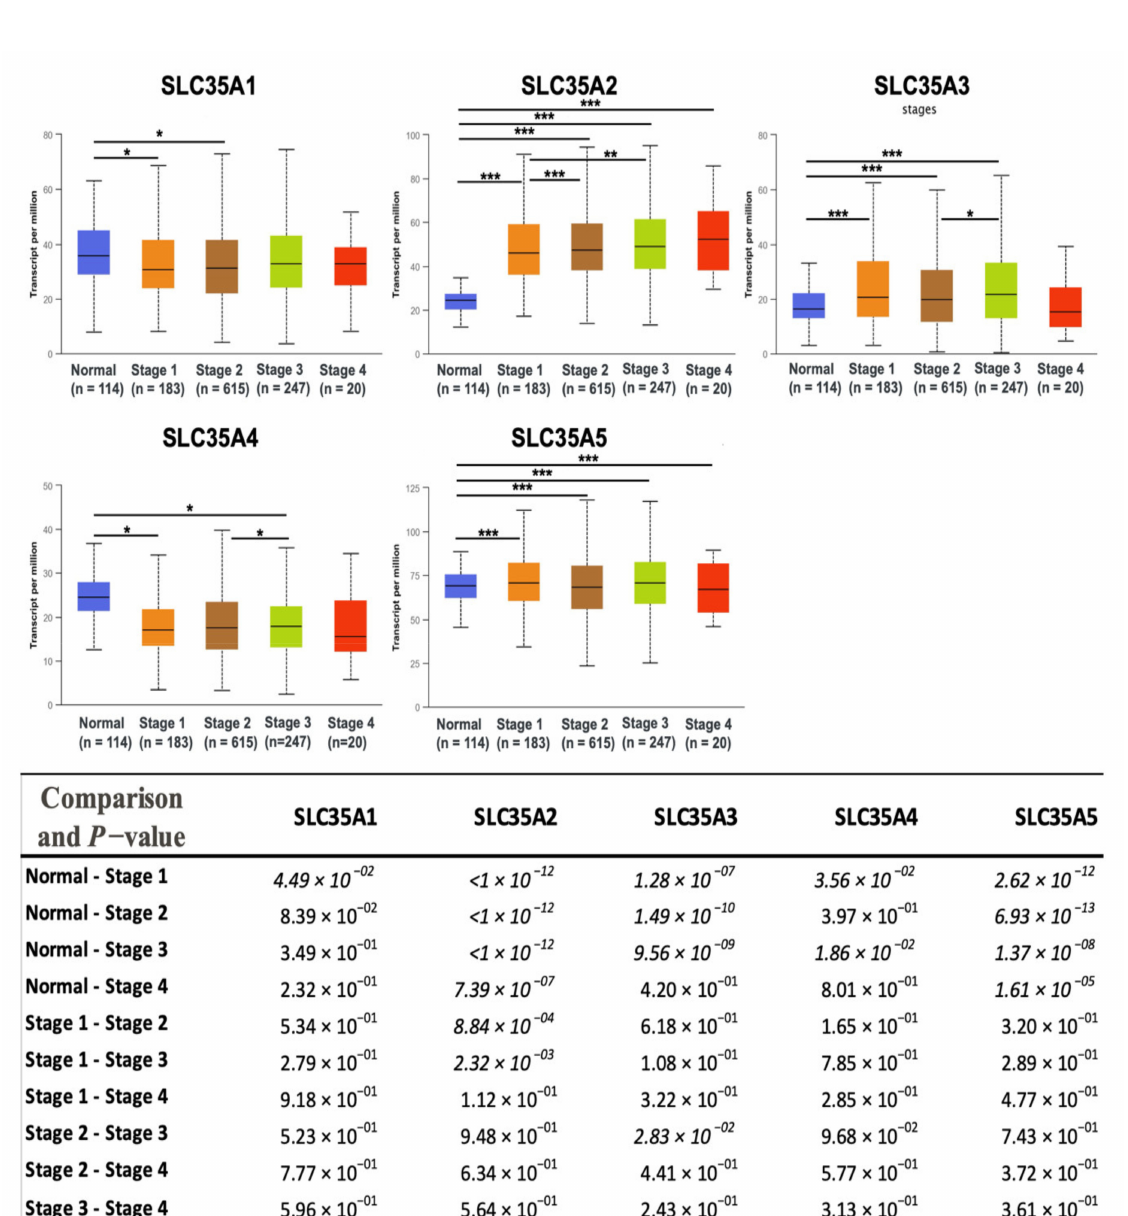
Figure 4. Solute carrier 35 A (SLC35A) transcription profiles in four stages of BRCA (UALCAN database). In the TCGA dataset, there were 114 normal samples, 183 patients at stage 1, 615 patients at stage 2, 247 patients at stage 3, and 20 patients at stage 4. Boxplots show relative expression levels of SLC35A family genes in healthy controls and stages 1, 2, 3, and 4 of breast cancer. Figure depicts expressions of SLC35A family genes (SLC35A1–SLC35A5) in breast cancer patients at individual cancer stages. Student’s t -test was conducted for statistical tests between groups. (* p < 0.05, ** p < 0.01, *** p <